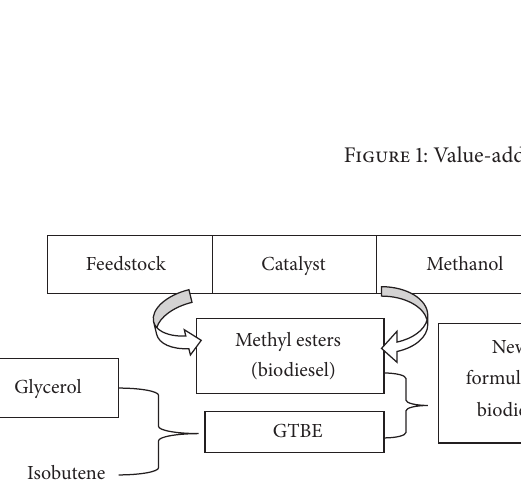
Figure 2: Biodiesel formulation using